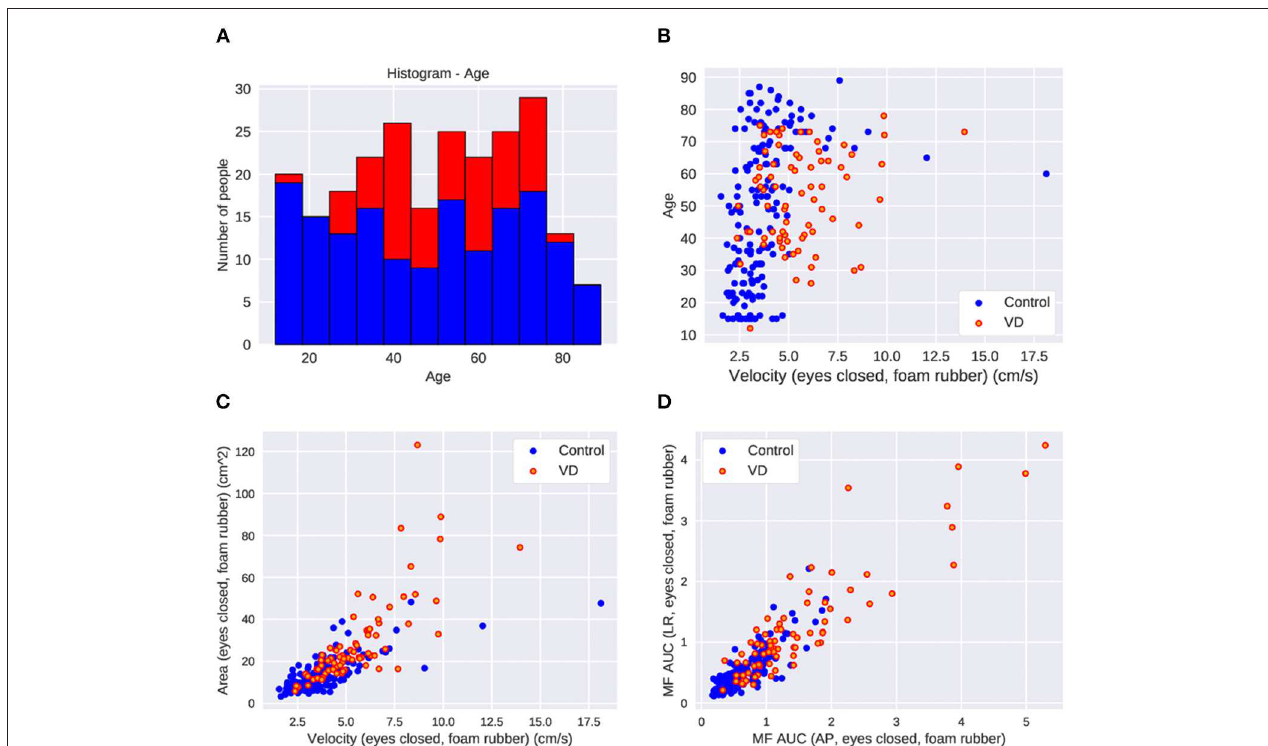
FIGURE 2 | The parameter distribution of the dataset in control and patients with vestibular dysfunction (VD). (A) Histogram of age. (B) Scatter plot of age and velocity of COP in the eyes-closed foam rubber condition. Greater VD cases at higher velocities. (C) Scatter plot of area and velocity in the eyes-closed foam rubber condition. More VD cases where the area and velocity are large. (D) Scatter plot of middle frequency AUC in the back and forth direction and middle frequency AUC in the left and right direction in the eyes-closed foam rubber condition. There are more VD patients in cases where each parameter is large.